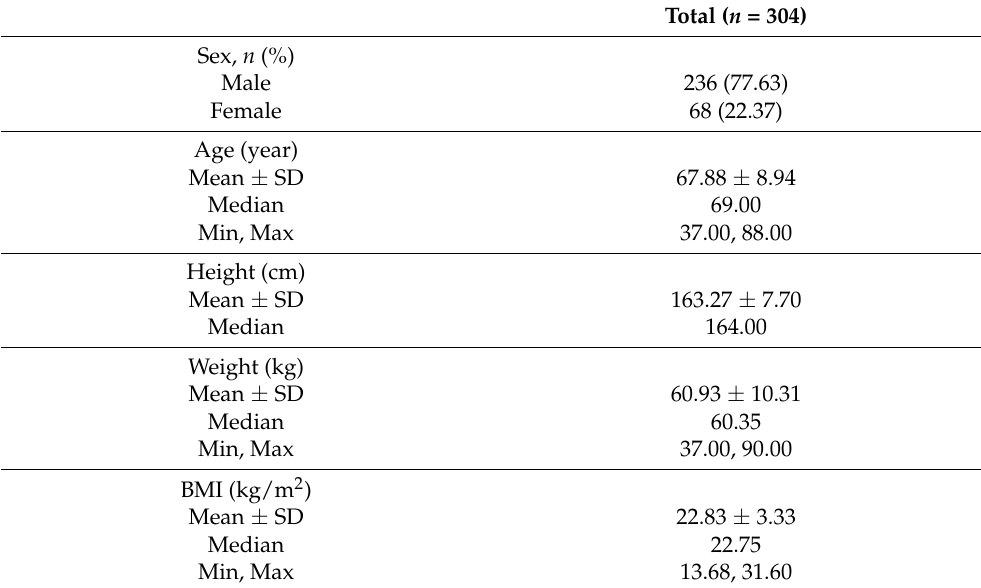
Table 1. Baseline characteristics of the study population.